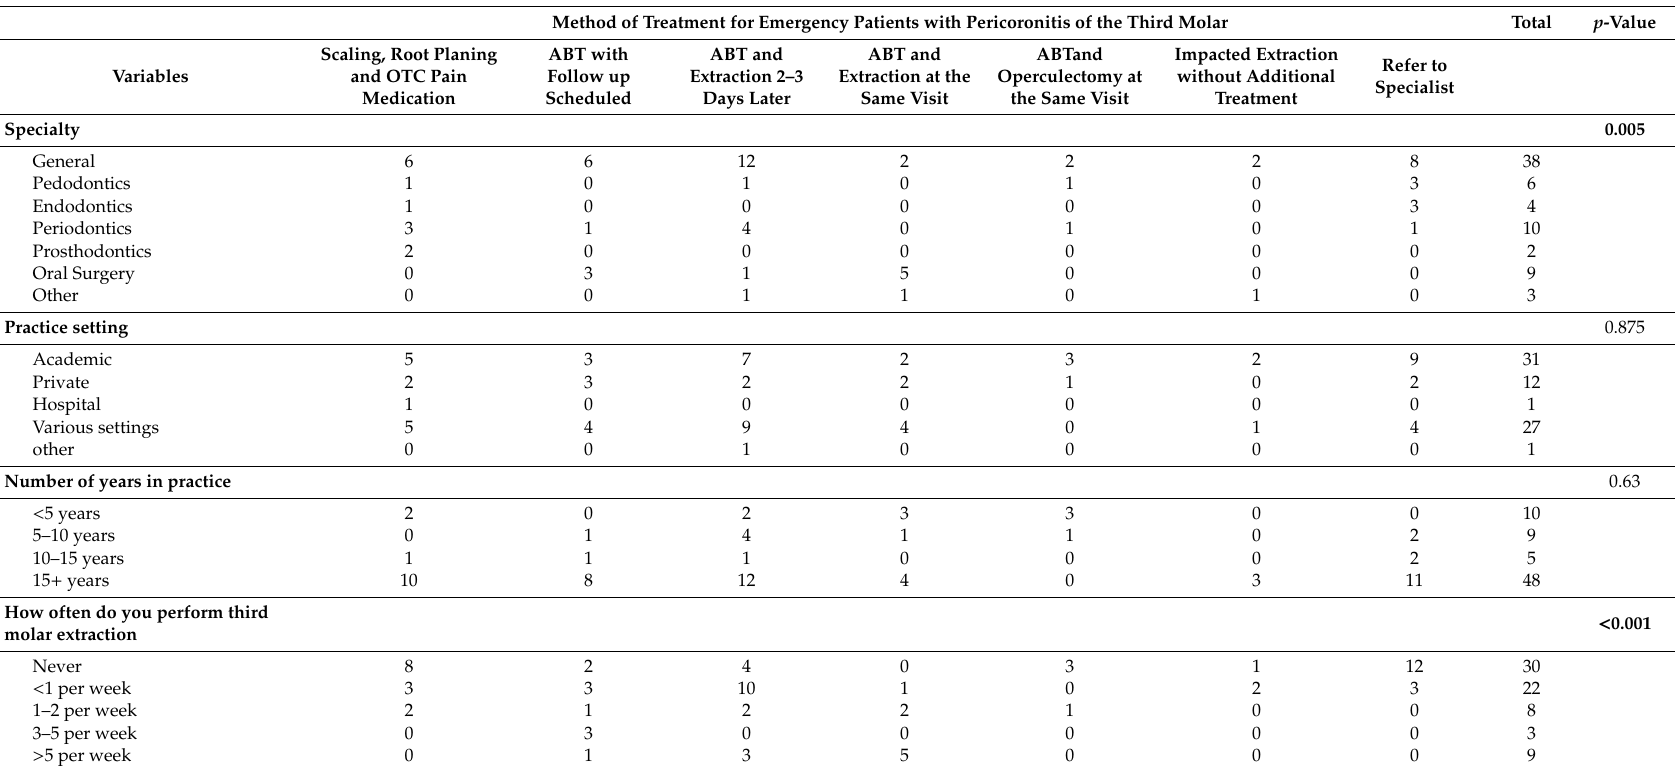
Table 2. Frequency of answers to survey’s question categorized based on the treatment method preferred for